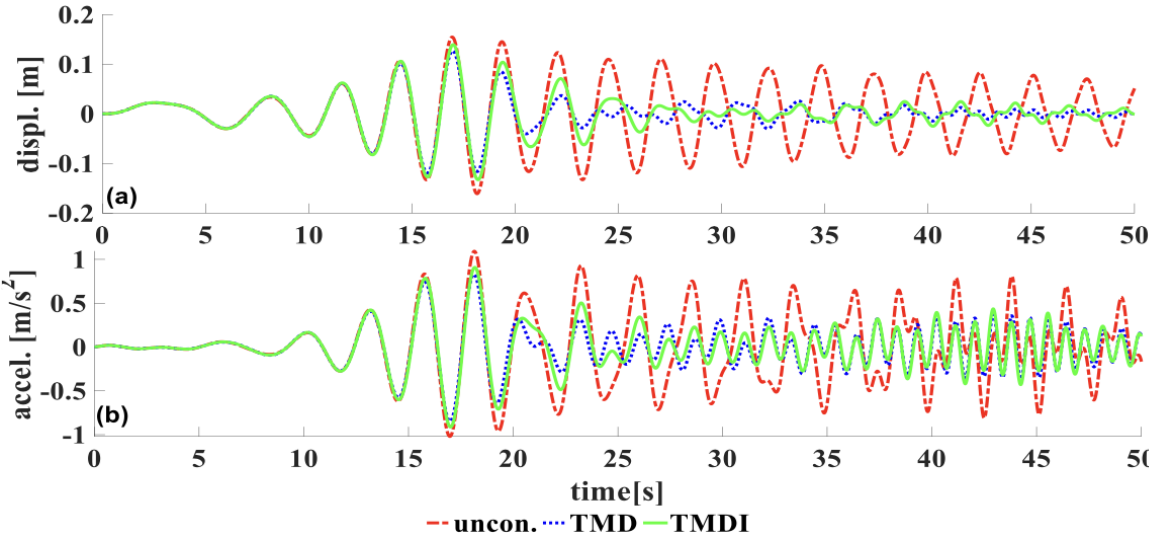
Figure 12. The response of the 42nd floor under VF sinewave loadings: ( a ) displacement time history and ( b ) acceleration time history.